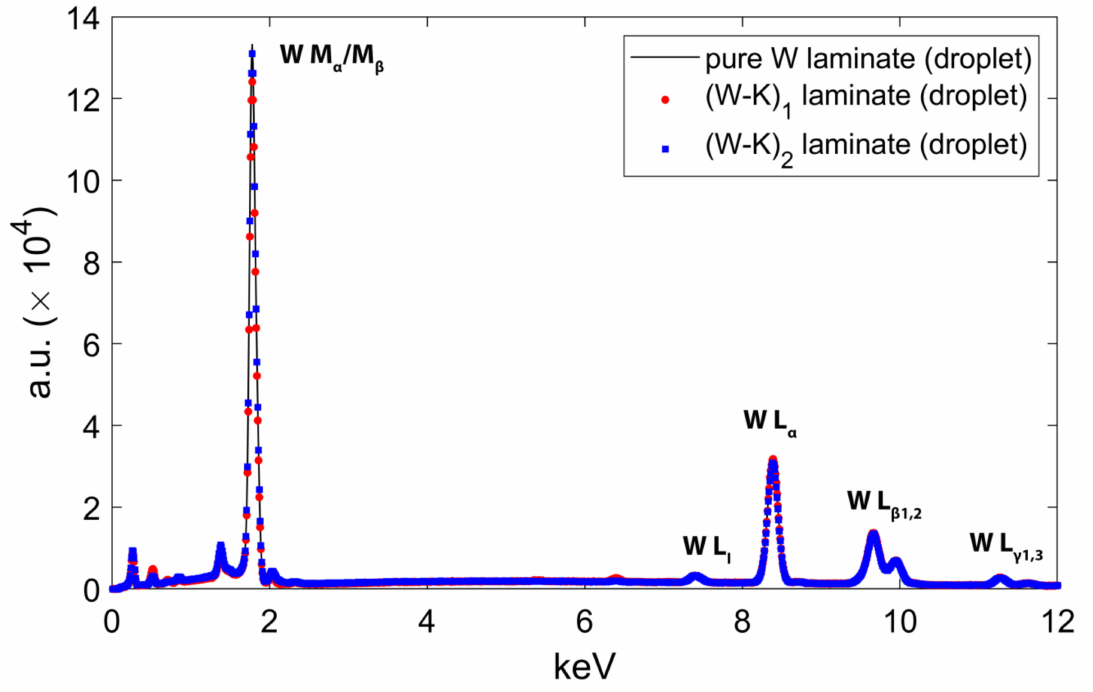
Figure 9. The X-ray spectra of pure W laminate droplet, (W-K) 1 laminate droplet and (W-K) 2 laminate